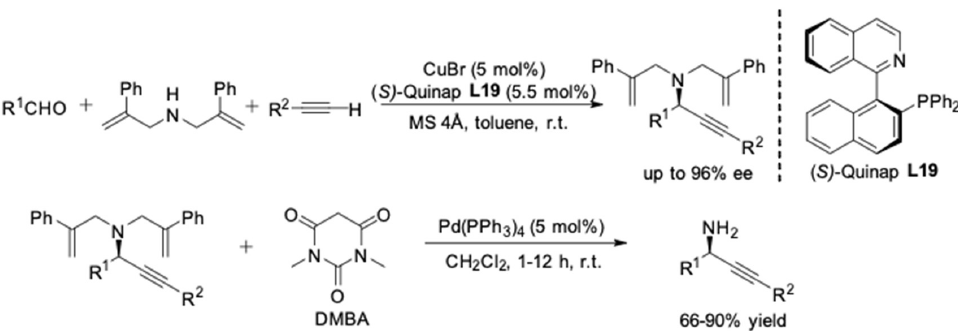
Figure 17. Asymmetric A 3 -couplings and deprotection to primary amines.